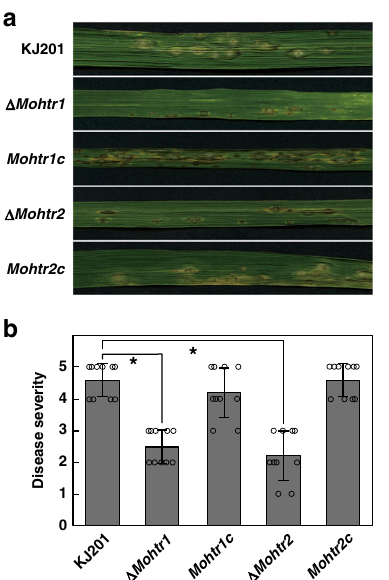
Fig. 5 The requirement of MoHTR1 and MoHTR2 for full virulence. 4- week-old Nakdong rice seedlings were sprayed with conidial suspensions (5 × 10 4 mL − 1 ) of KJ201 (wild type), two MoHTR knockout mutants, and complemented mutant strains. a Representative infected leaves were collected at 7 dpi, and b quanti fi ed data are shown. n = 10 independently